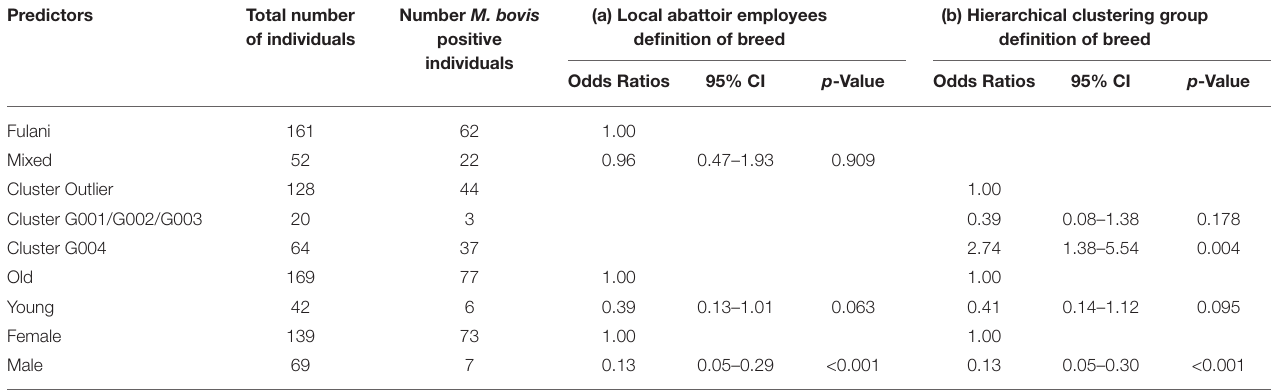
TABLE 1 | Association between M. bovis and (a) local abattoir employees definition of breed and (b) hierarchical clustering group definition of breed after accounting for age and sex ( n = 207). Predictors Total number Number M. bovis of individuals positive